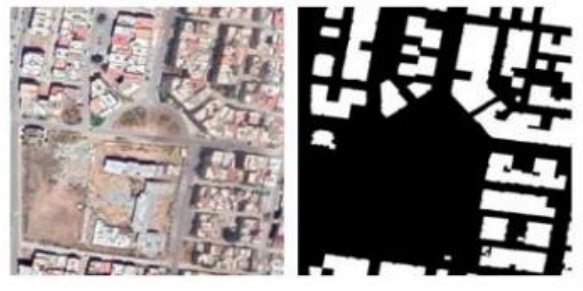
Fig.5. Satellite Image and its Mask.